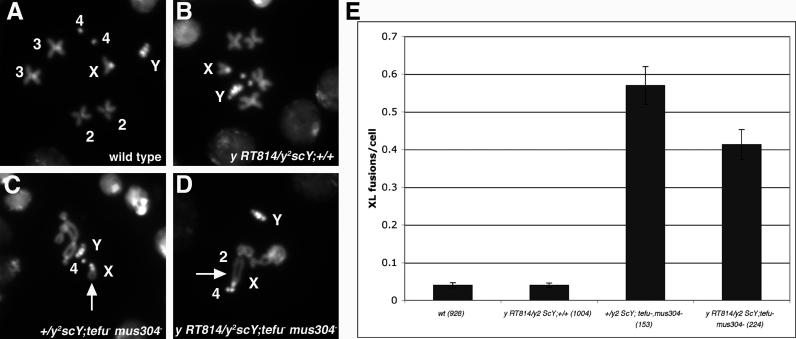
The Drosophila tefu and mei-41-mus304 Pathways Act in an Epigenetic Telomere Protection MechanismNormal (A) and terminally deleted (B) X chromosomes are not fused in wild-type cells. Normal (C) and terminally deleted X chromosomes (D) are fused in tefu mus304 double mutant cells. Both sister chromosome fusions (C) and non-sister fusions (D) are observed. High frequencies of X chromosome telomere fusions per cell are observed for normal and terminally deleted chromosomes in tefu mus304 mutant cells (E). Error bars indicate the standard error of the mean. The number of cells scored for each genotype is in parenthesis. The labels X, Y, 2, 3, and 4 refer to the relevant chromosome.